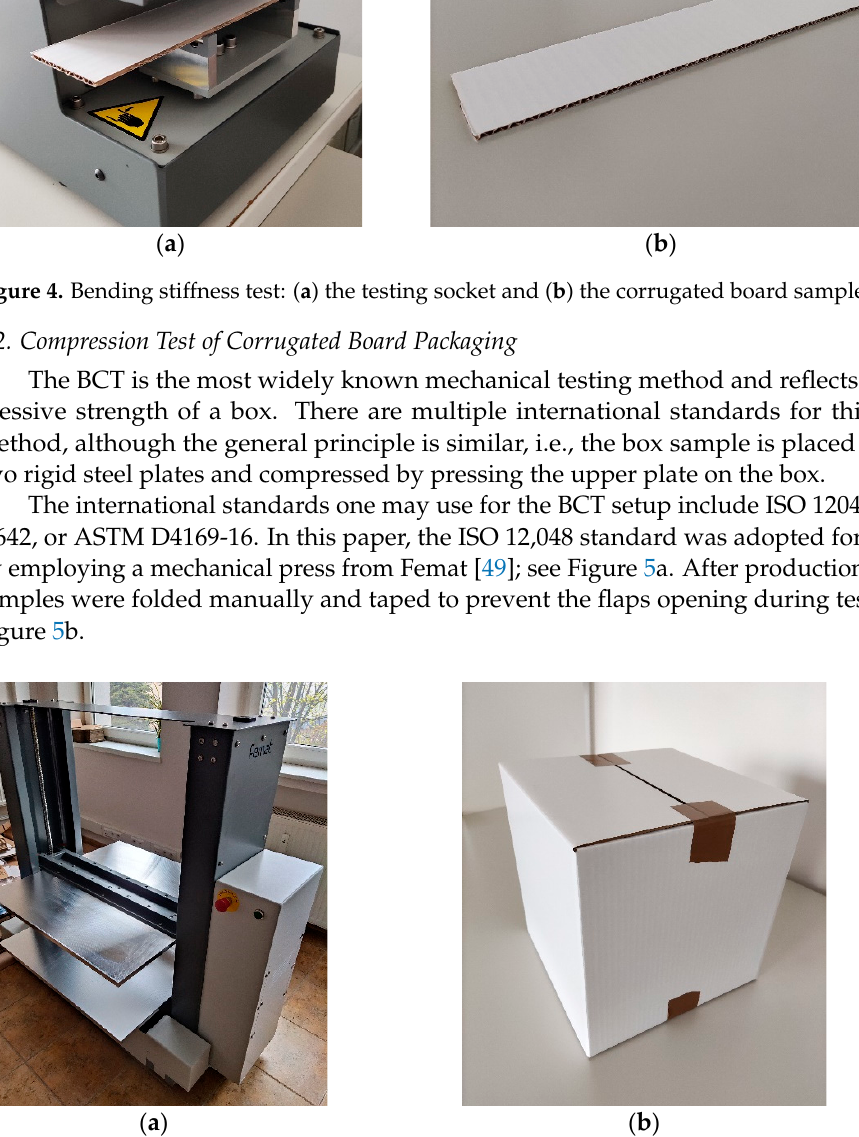
Figure 3. Torsion stiffness test: ( a ) the testing socket and ( b ) the corrugated board sample.